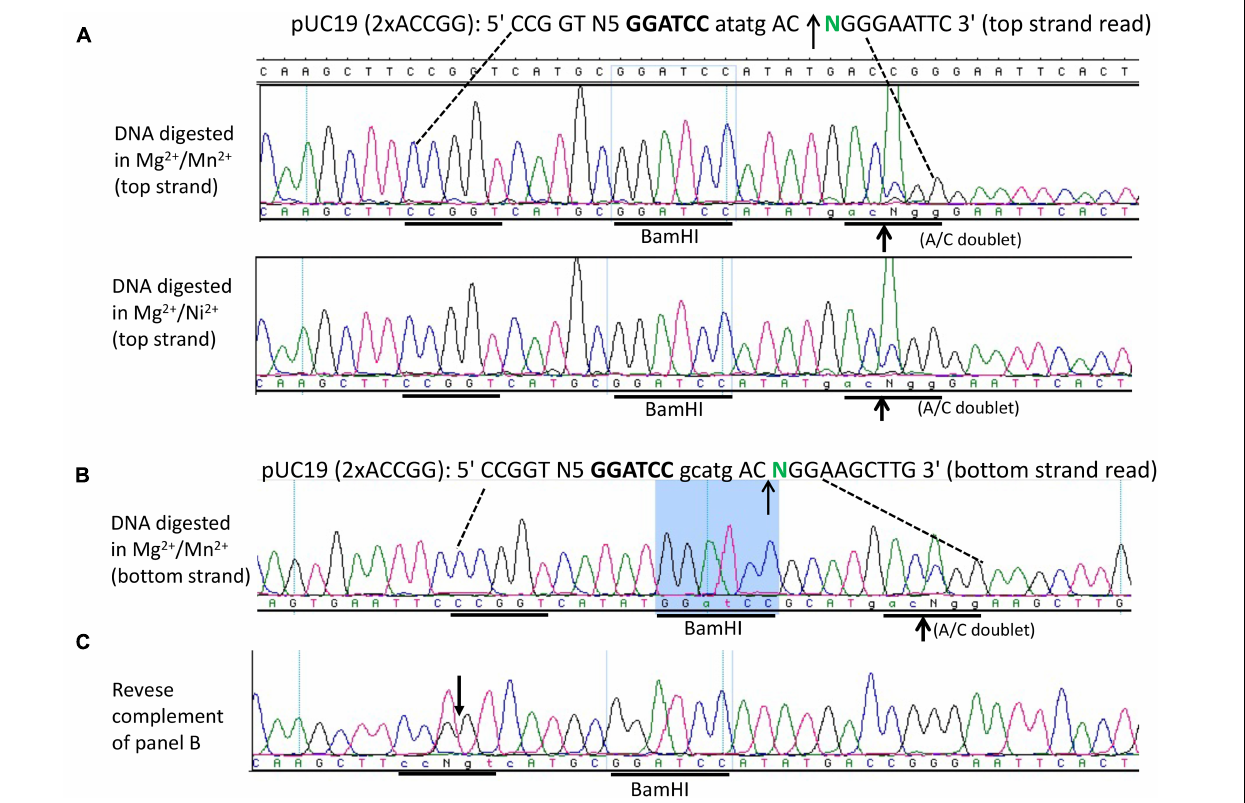
FIGURE 5 | DNA run-off sequencing of the nicking sites and nicking distance from the Bam HI site. (A) Top-strand sequencing read from nicked bottom strand. Nicking reactions were carried out in NEB buffer 2 supplemented with MnCl 2 (1 mM) or NiCl 2 (1 mM) using pUC19 (2xACCGG) containing the composite site 5 (cid:48) CCGGT-N5-GGATCC-N5 ACCGG 3 (cid:48) . The duplex oligos containing the composite site was inserted into pUC19 and flanked by Hin dIII (AAGCTT) and Eco RI (GAATTC) sites. (B) Bottom-strand sequencing read (nicked top-strand template) near the Bam HI site. The composite site contains a nick as indicated by a strong A/C doublet. If the bottom strand is shown as a reverse-complement, a T/G doublet would be present (C) in the nicking